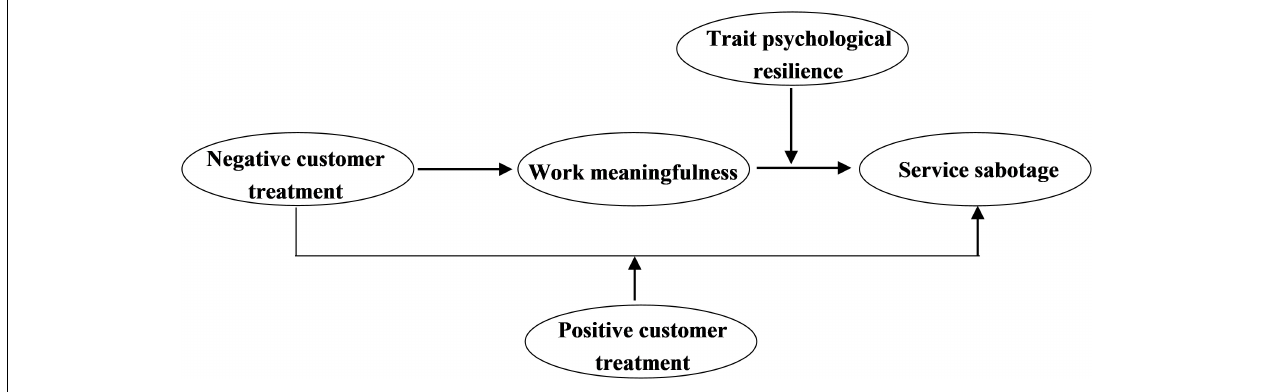
FIGURE 1 | The proposed